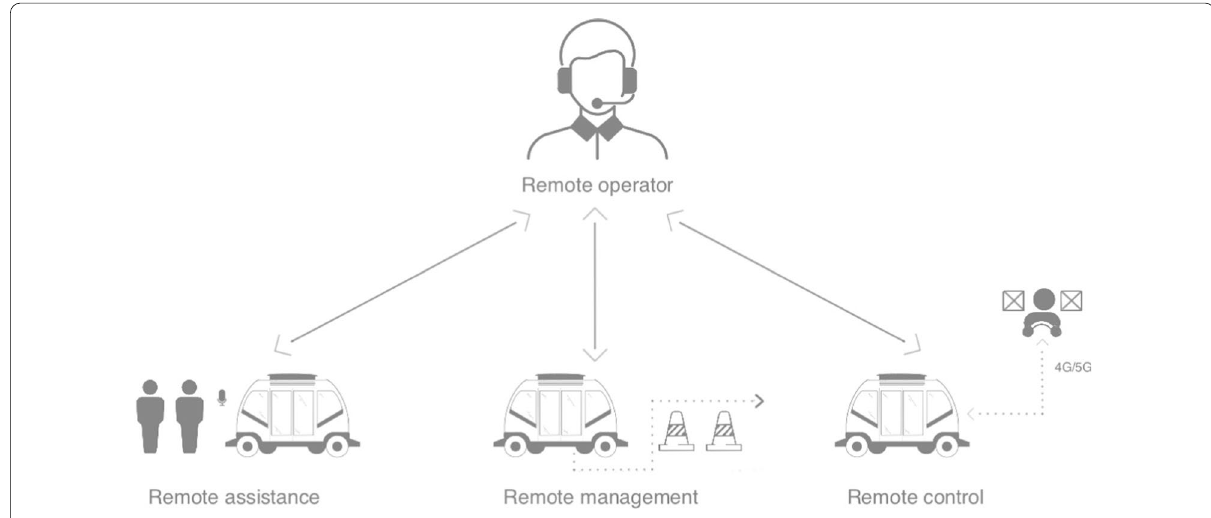
Fig. 4 Visualisation of the roles a remote operator may provide to an AV in the event of an edge